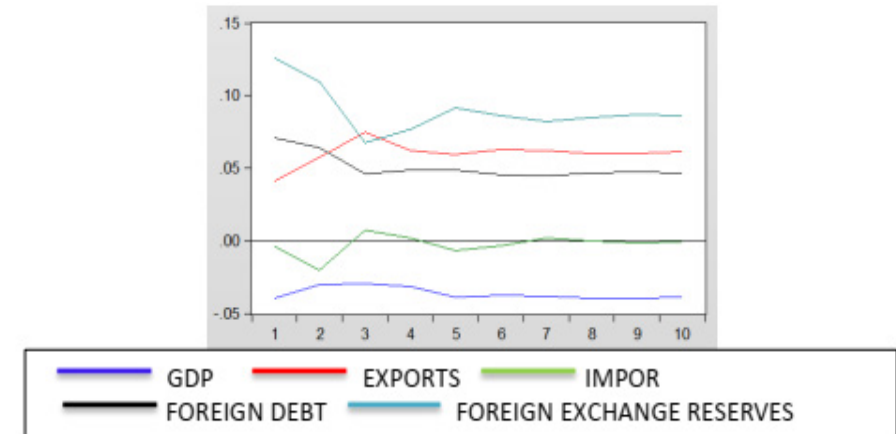
Figure 4: IRF Graphics of Response Foreign Exchange Reserves